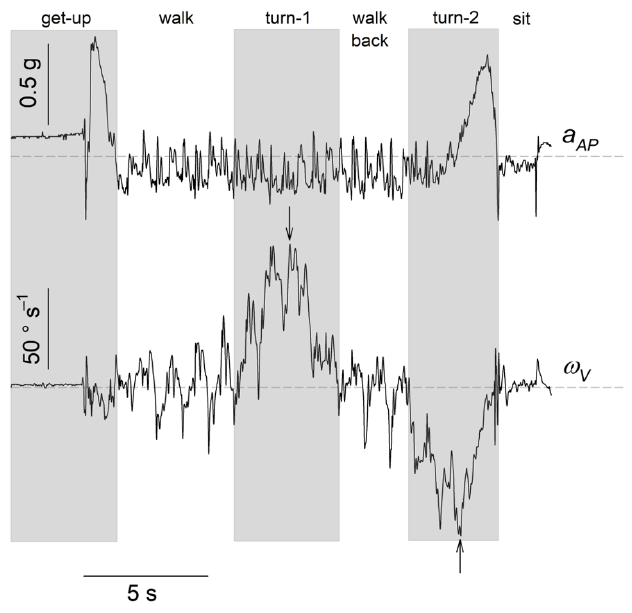
Figure 1. Typical traces of the AP acceleration ( a AP ) and of the V angular velocity ( ω V ) during TUG. Acceleration is expressed in a fraction of g = 9.81 m s − 2 , and angular velocity is expressed in ◦ s − 1 . White/gray areas highlight the different subtasks of the TUG. Arrows indicate the peak angular velocity during the two half-turns. Horizontal grey dashed lines show zero